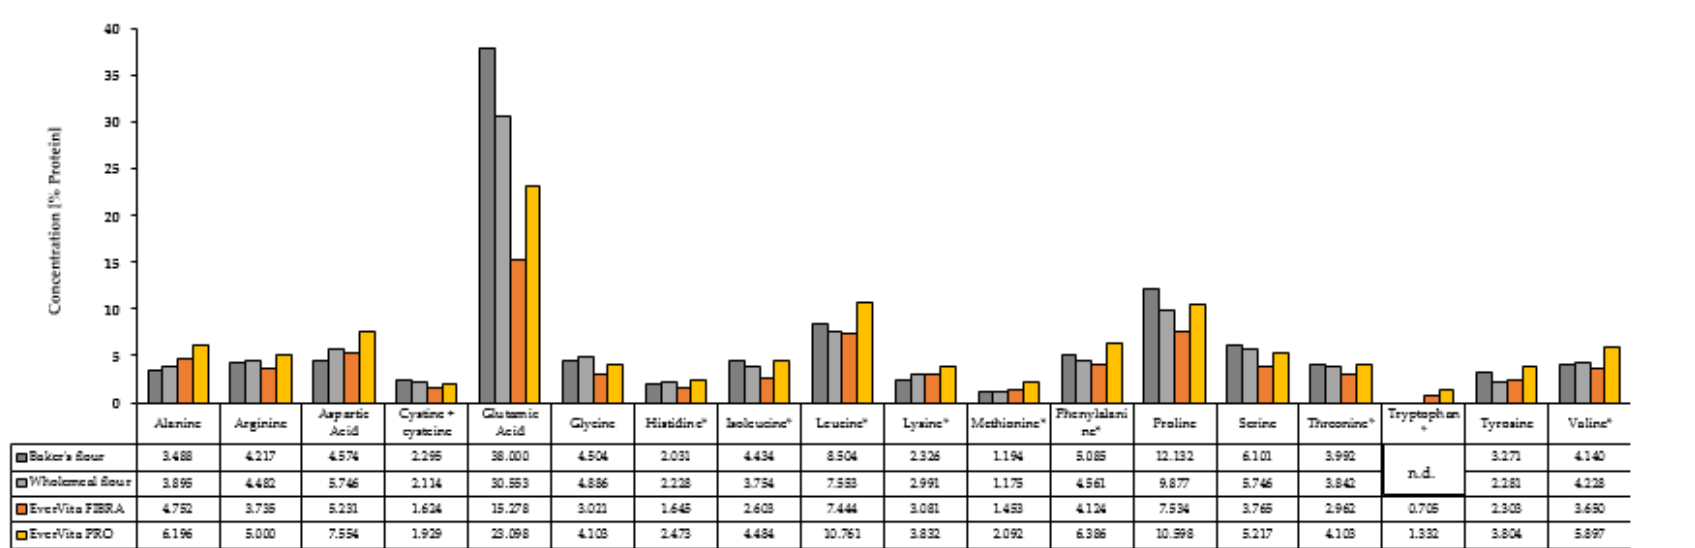
Figure 2. Amino acid composition of the raw ingredients baker’s flour, wholemeal flour and EverVita ingredients, EverVita FIBRA and EverVita PRO, in % based on protein. Values are expressed as mean values with a coefficient of variation < 0.1. * Indispensable amino acids. n.d. stands for ‘not detected’.